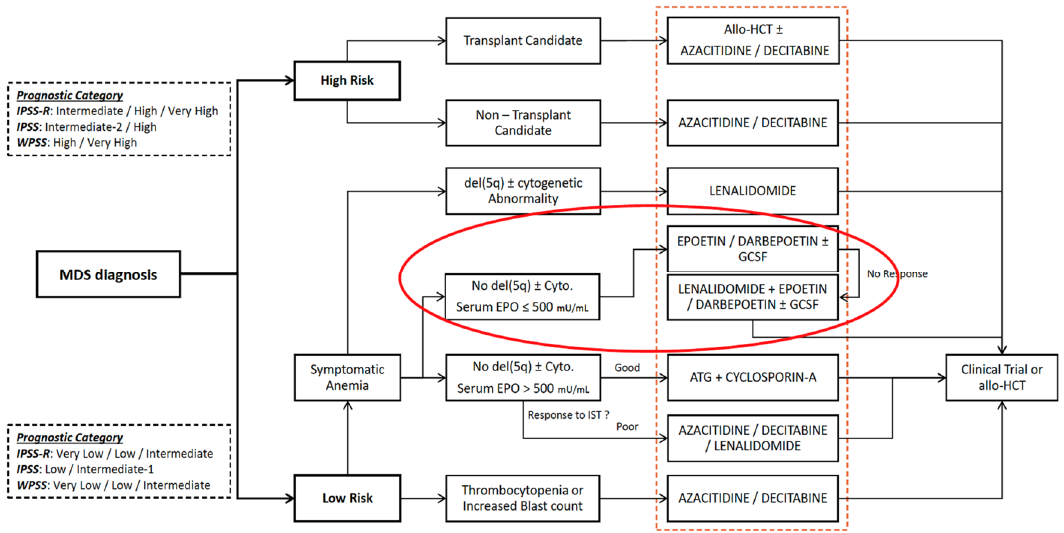
Figure 1. NCCN Guidelines for the Treatment of MDS. The orange dashed box highlights all treatment recommendations for MDS. The red circle highlights treatment options for non-del(5q) MDS.